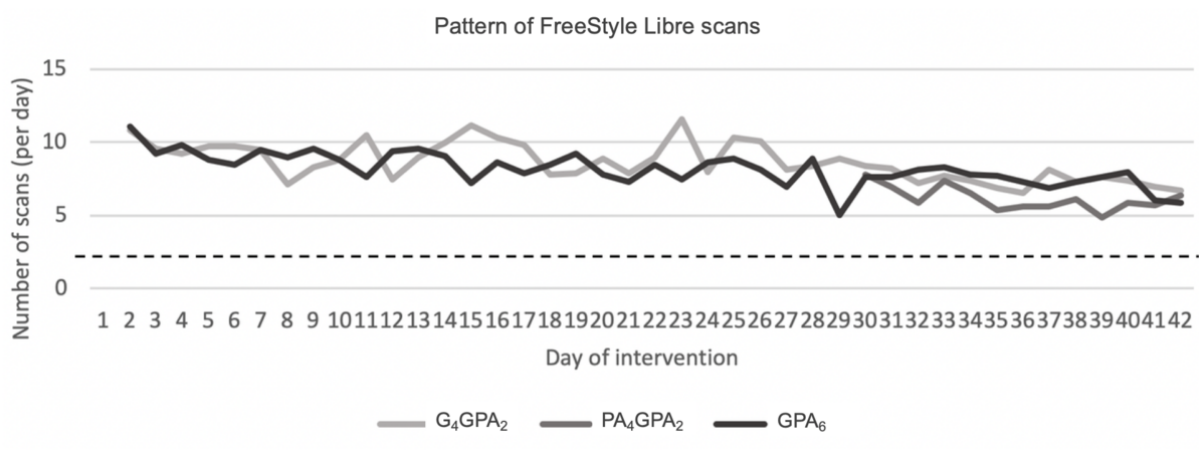
Figure 3. Pattern of participant scans of the glucose sensor over the 6 weeks, with the horizontal line reflecting the recommended minimum number of scans per day. One participant recorded 173 scans on day 12, deemed an outlier, and so was excluded from this figure. G 4 GPA 2 : Group 1; PA 4 GPA 2 : Group 2; GPA 6 : Group